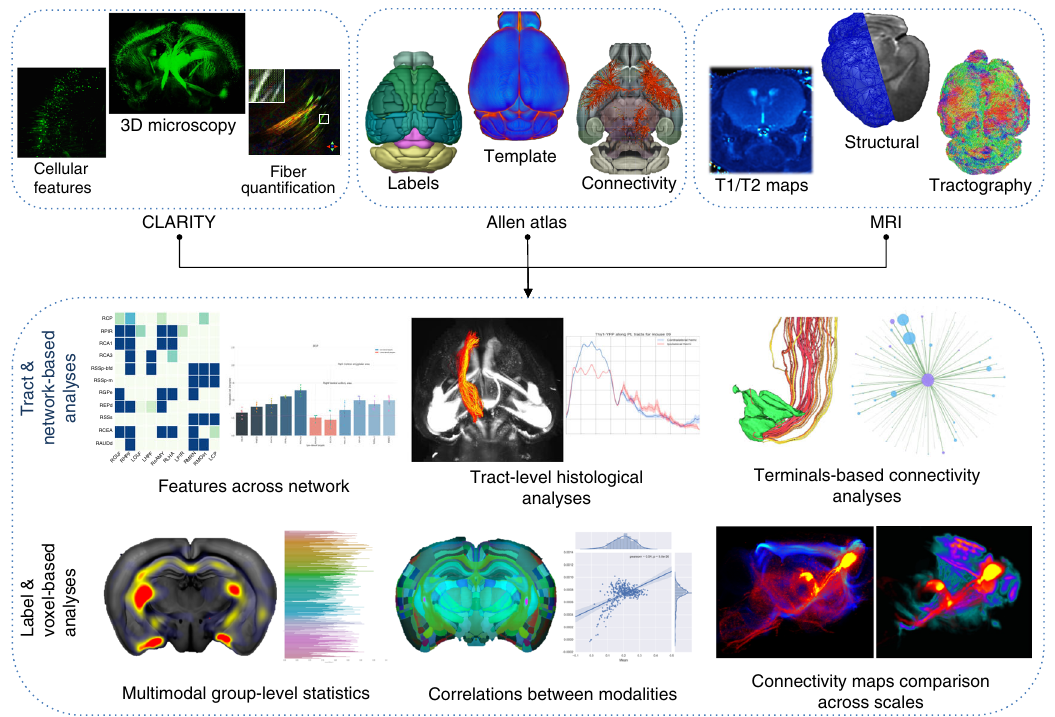
Fig. 1 MIRACL enables the interrogation of brain pathways and cellular features across modalities. The resource integrates CLARITY data in the microscopic domain (top left) with macroscopic in vivo and ex vivo imaging data, such as structural MR, diffusion MR, and quantitative MR relaxometry (top right), in the Allen atlas reference frame “ ARA ” (top center). This integration enables tract and network-based analyses such as studies of histological features across network graphs or along fi ber tracts and connectivity analyses based on projection terminals. This pipeline also performs group-level statistics, multimodal correlations, as well as comparisons of connectivity maps across